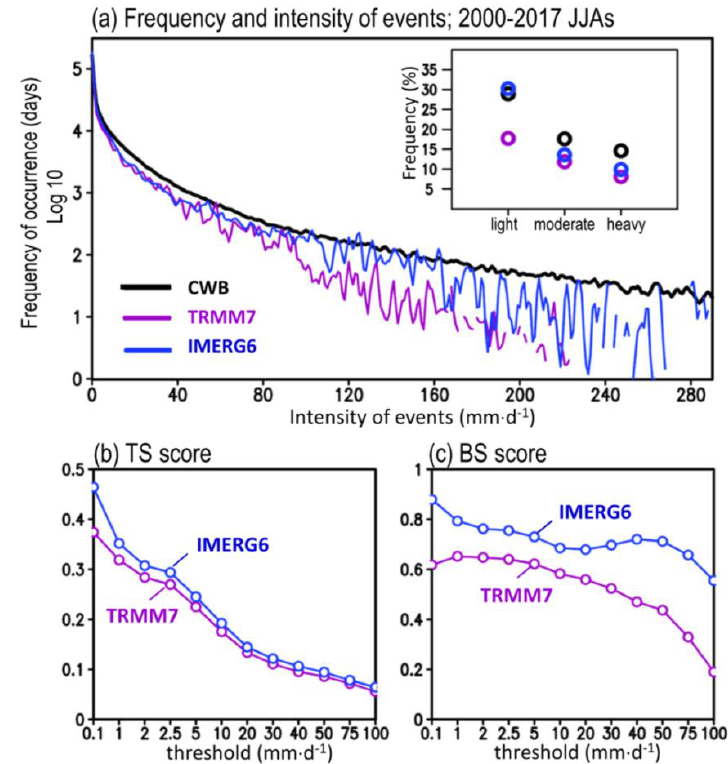
Figure 3. ( a ) Histograms of the frequency of occurrence as a function of daily precipitation intensity (bin size is 1 mm · d − 1 ) in Taiwan during the summers of 2000–2017. Inset plots represent the frequency (in %) of light (0.1–5 mm · d − 1 ), moderate (5–20 mm · d − 1 ), and heavy precipitation ( > 20 mm · d − 1 ) events. The method used for generating ( a ) follows Sun et al. [43]. ( b ) and ( c ) is the value of TS and BS (explained in Section 2), respectively, for the comparison between CWB data and two SPPs (IMERG6 and TRMM7) during the summers of 2000–2017. The sample size used here is 92 (days per JJA) × 18 (JJAs) × 392 (grid points per day) = 649152 grid points.